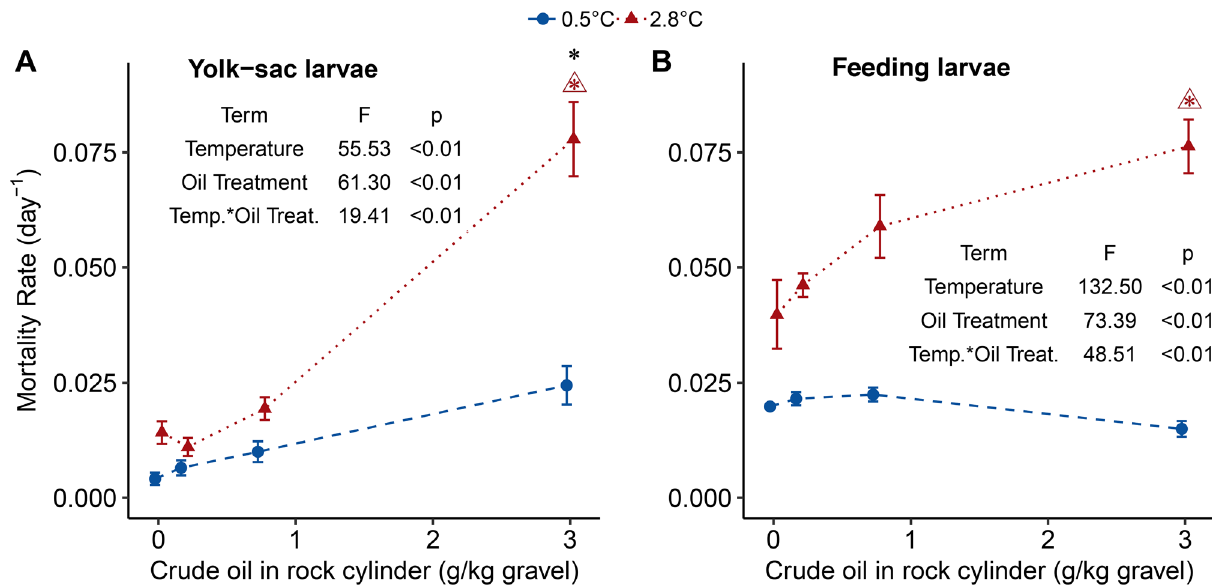
Figure 5. The effect of temperature and WSF crude oil exposure on instantaneous mortality rates for ( A ) yolk-sac larvae [day 27–46 (2.8 °C); day 40–68 (0.5 °C)] and ( B ) feeding larvae [day 47–52 (2.8 °C); day 69–76 (0.5 °C)]. Data is displayed as treatment means (± SEM depicted as bars, each treatment is represented by four independent incubators). Colors and symbols indicate temperature groups and dashed and dotted lines represent the trend line for each temperature group. The terms of the best LME models for each stage are displayed in the respective panels with the associated ANOVA test F-values and p-values. An asterisk (*) above a treatment group indicates a statistically significant difference from the unexposed group, a triangle (open triangle) with an asterisk indicates a statistically significant interaction between temperature and crude oil exposure at the adjacent crude oil treatment